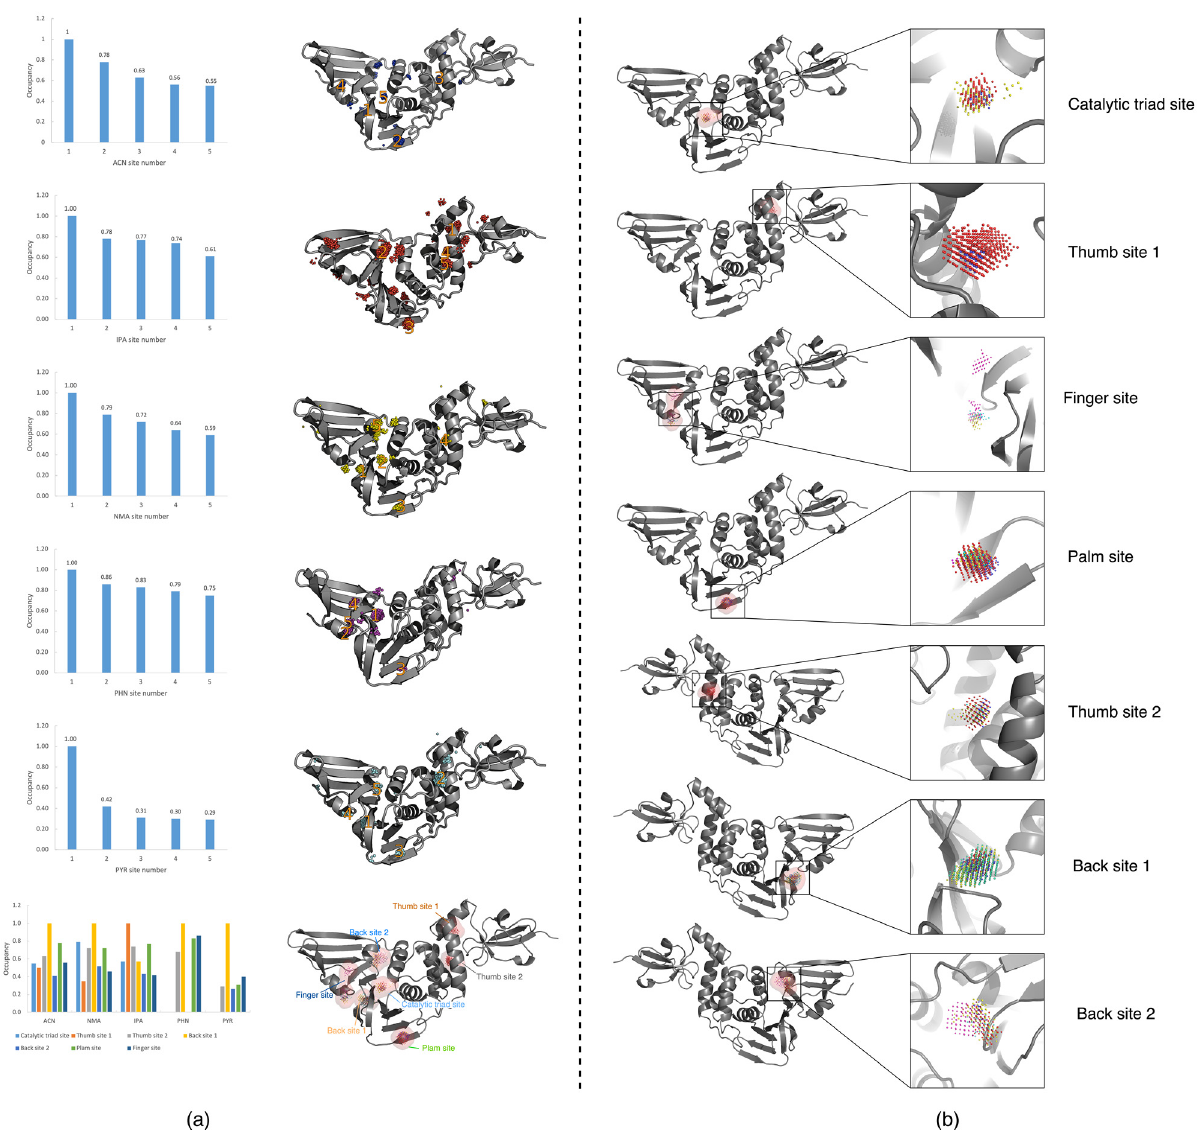
Figure 4. Probeview results: ( a ) Density ranking and location of sites in the PLpro MixMD maps. From top to bottom are ACN, NMA, IPA, PHN, PYR MixMD system density ranking and statistics of the scores of the main sites. ( b ) Distribution of probe molecules at the main sites. The occupancy points are coloured to different probes: ACN (blue), IPA (red), NMA (yellow), PHN (purple), and PYR (cyan).